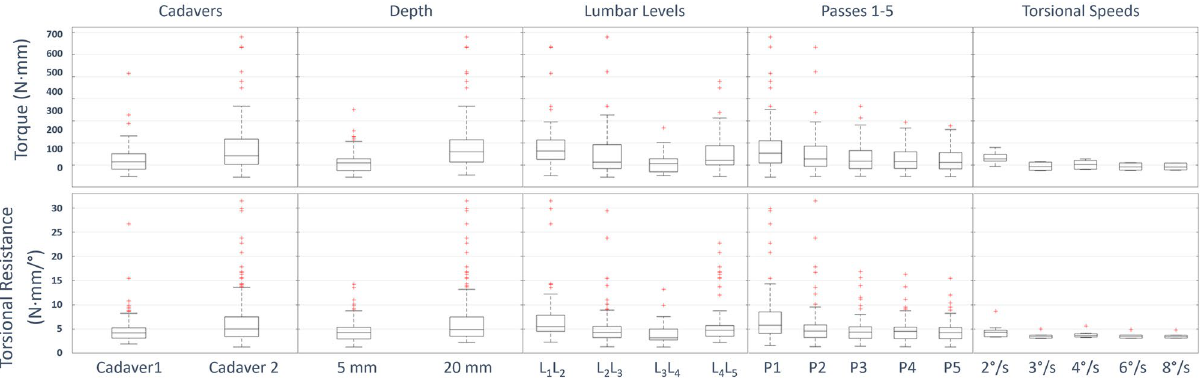
Figure 5. Torque peak and torsional resistance